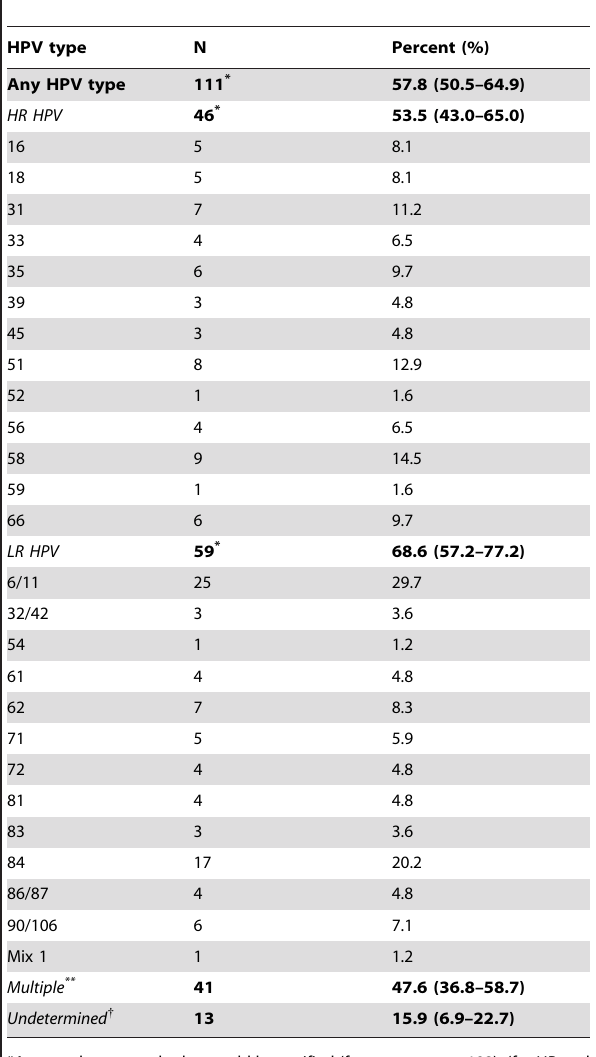
Table 2. Prevalence of Anal Human Papillomavirus (HPV) types